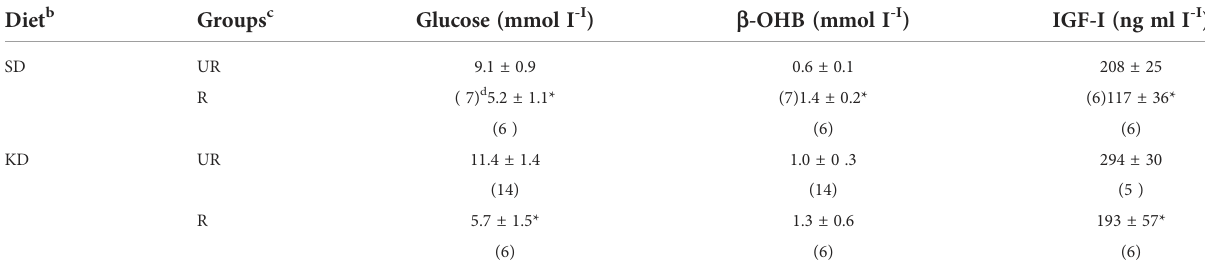
TABLE 1 In fl uence of diet on plasma glucose, b -OHB, and IGF-I levels in mice bearing the CT-2A intracerebral brain tumour a . Diet b